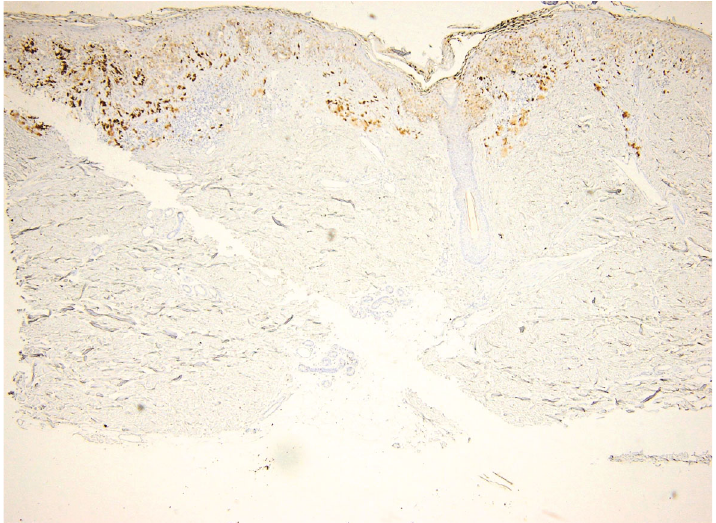
Figure 6: FOXP3 expression in melanoma: notice the presence of positive tumor cells and lymph cells. FOXP3 immunoassay, magni fi cation 40x.